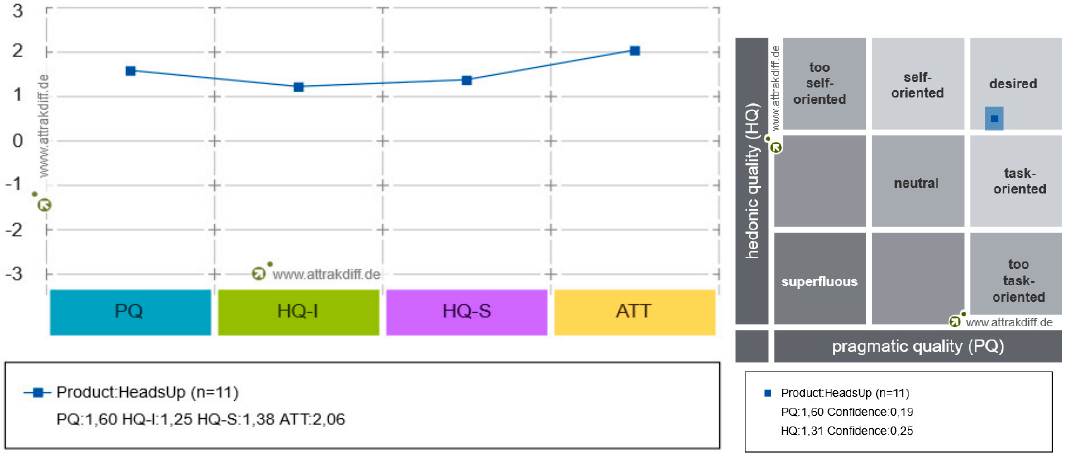
Figure 4. Overall AttrakDiff